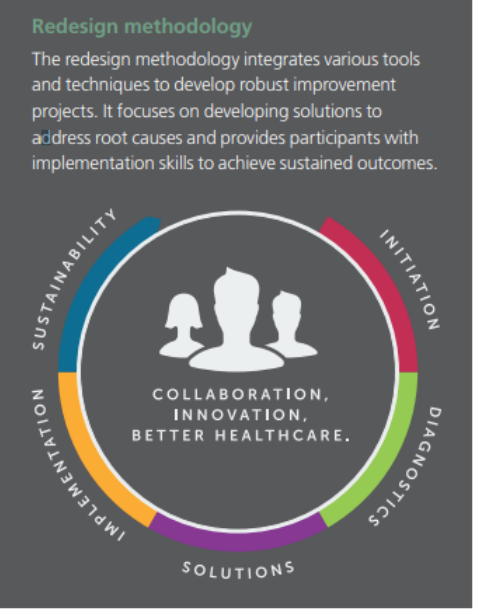
Figure 1. Redesign Methodology.